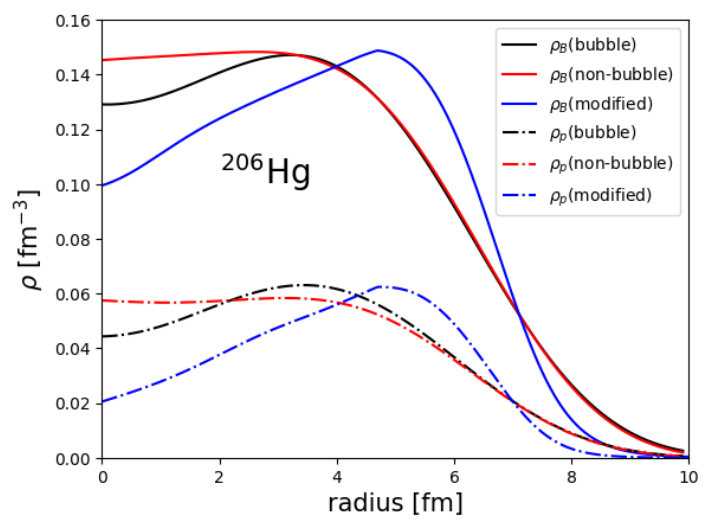
Figure 2. Comparison between initialized total (red or black solid lines) and proton (red or black dash-dotted lines) density distributions as a function of the radius of 206 Hg. To secure the bubble structure of the initialized 206 Hg, we used the rescaled nucleon density profile (blue lines) for the initialization of 206 Hg with bubble